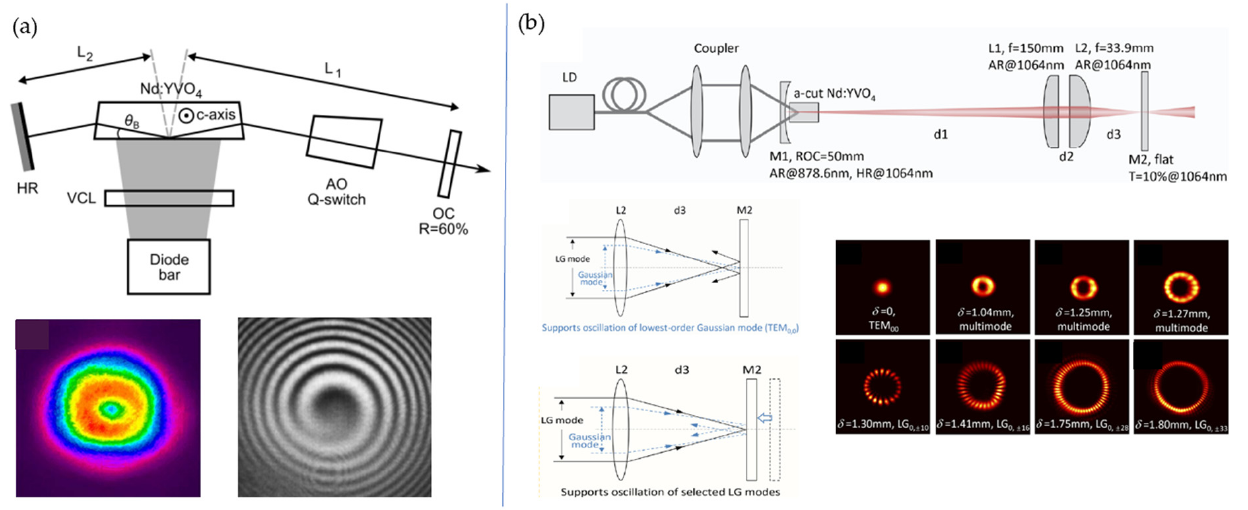
Figure 8. ( a ) Stigmatic Nd:YVO 4 bounce oscillator. Reprinted with permission from [125] © Springer-Verlag 2009; ( b ) LG mode selection by enhanced intracavity spherical aberration. Reprinted with permission from [126] © The Optical Society.